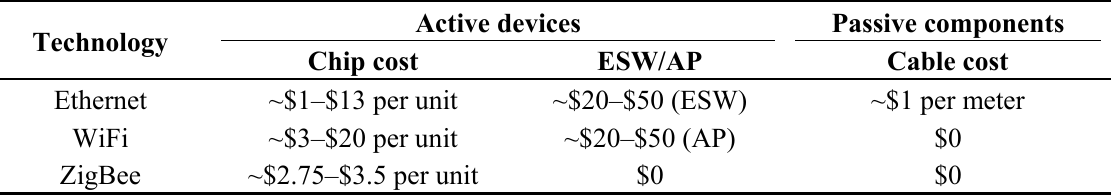
Table 12. Implementation cost for different communication technologies